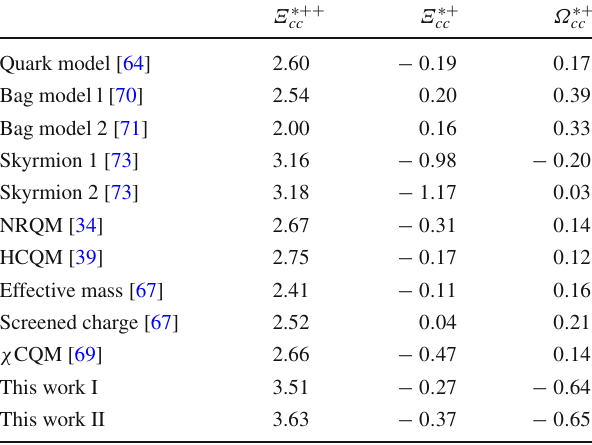
Table 5 Comparison of the spin- 3 doubly charmed baryons mag- 2 netic moments in the literature including the quark model [64], MIT bag model [70,71], skyrmion model [73], non-relativistic quark model (NRQM) [34], hyper central model (HCQM) [39], effective mass and